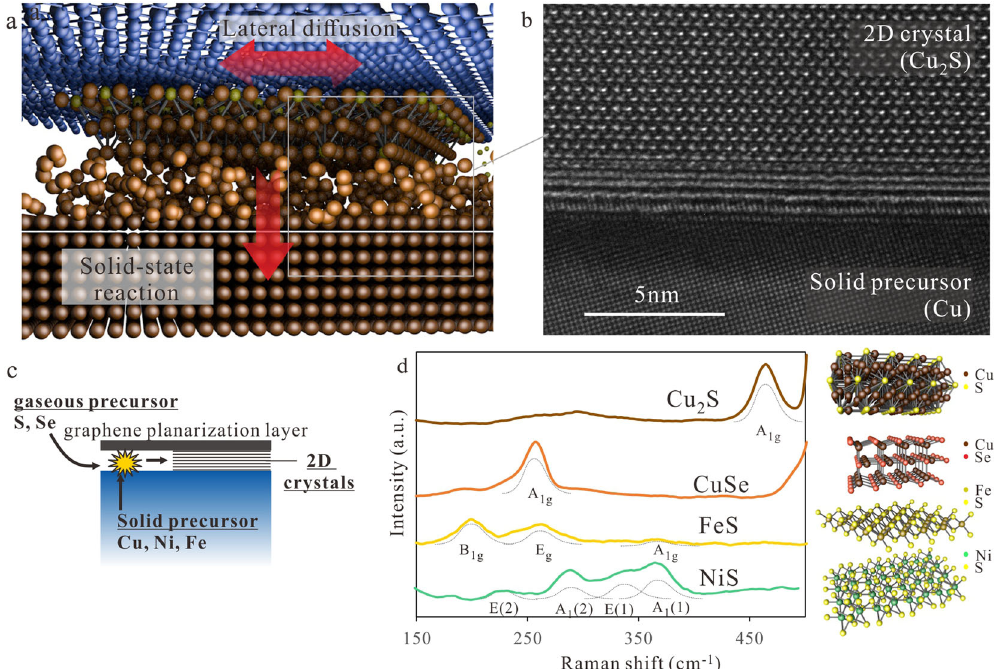
Fig. 1 Planarized solid-state chemical reaction. a Schematic of the planarized reaction process with indications of enhanced lateral diffusion and occuring reaction. b cross-sectional TEM image of copper/2D crystal interface indicated in a (the transition region exhibits FIB-induced amorphization of Cu 53 ). c Schematic of experimental realization of 2D crystal growth, d Raman spectra of obtained materials with indication of assigned modes for high-chalcocite (Cu 2 S) 54 , covellite (CuSe) 55 , mackinawite (FeS) 56 , millerite (NiS) 57 and corresponding crystal